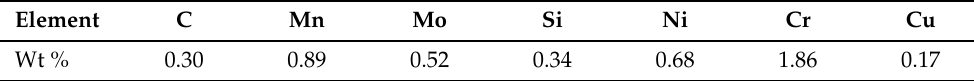
Table 1. Chemical composition of medium carbon steel. Fe = balance. Element